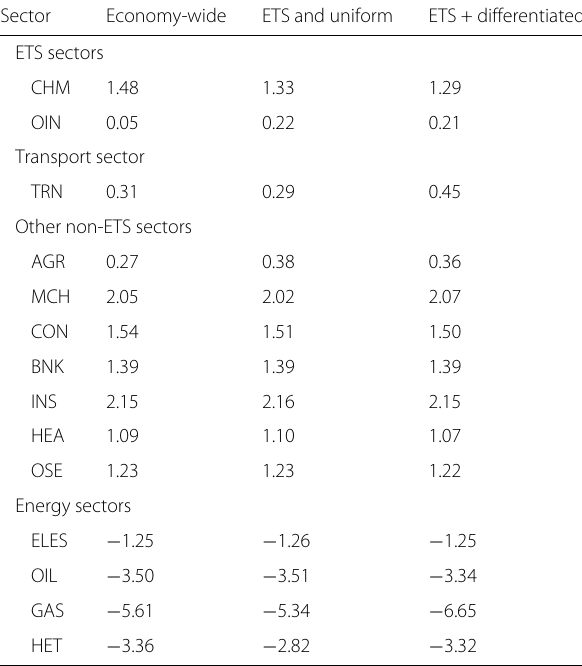
Table 5 2010–2050 growth rate of output (in percentage)